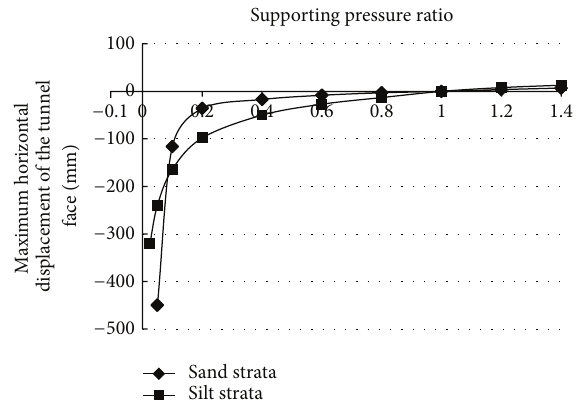
Figure 11: The transverse ground settlements ahead of tunnel face after collapse failure of the tunnel face.